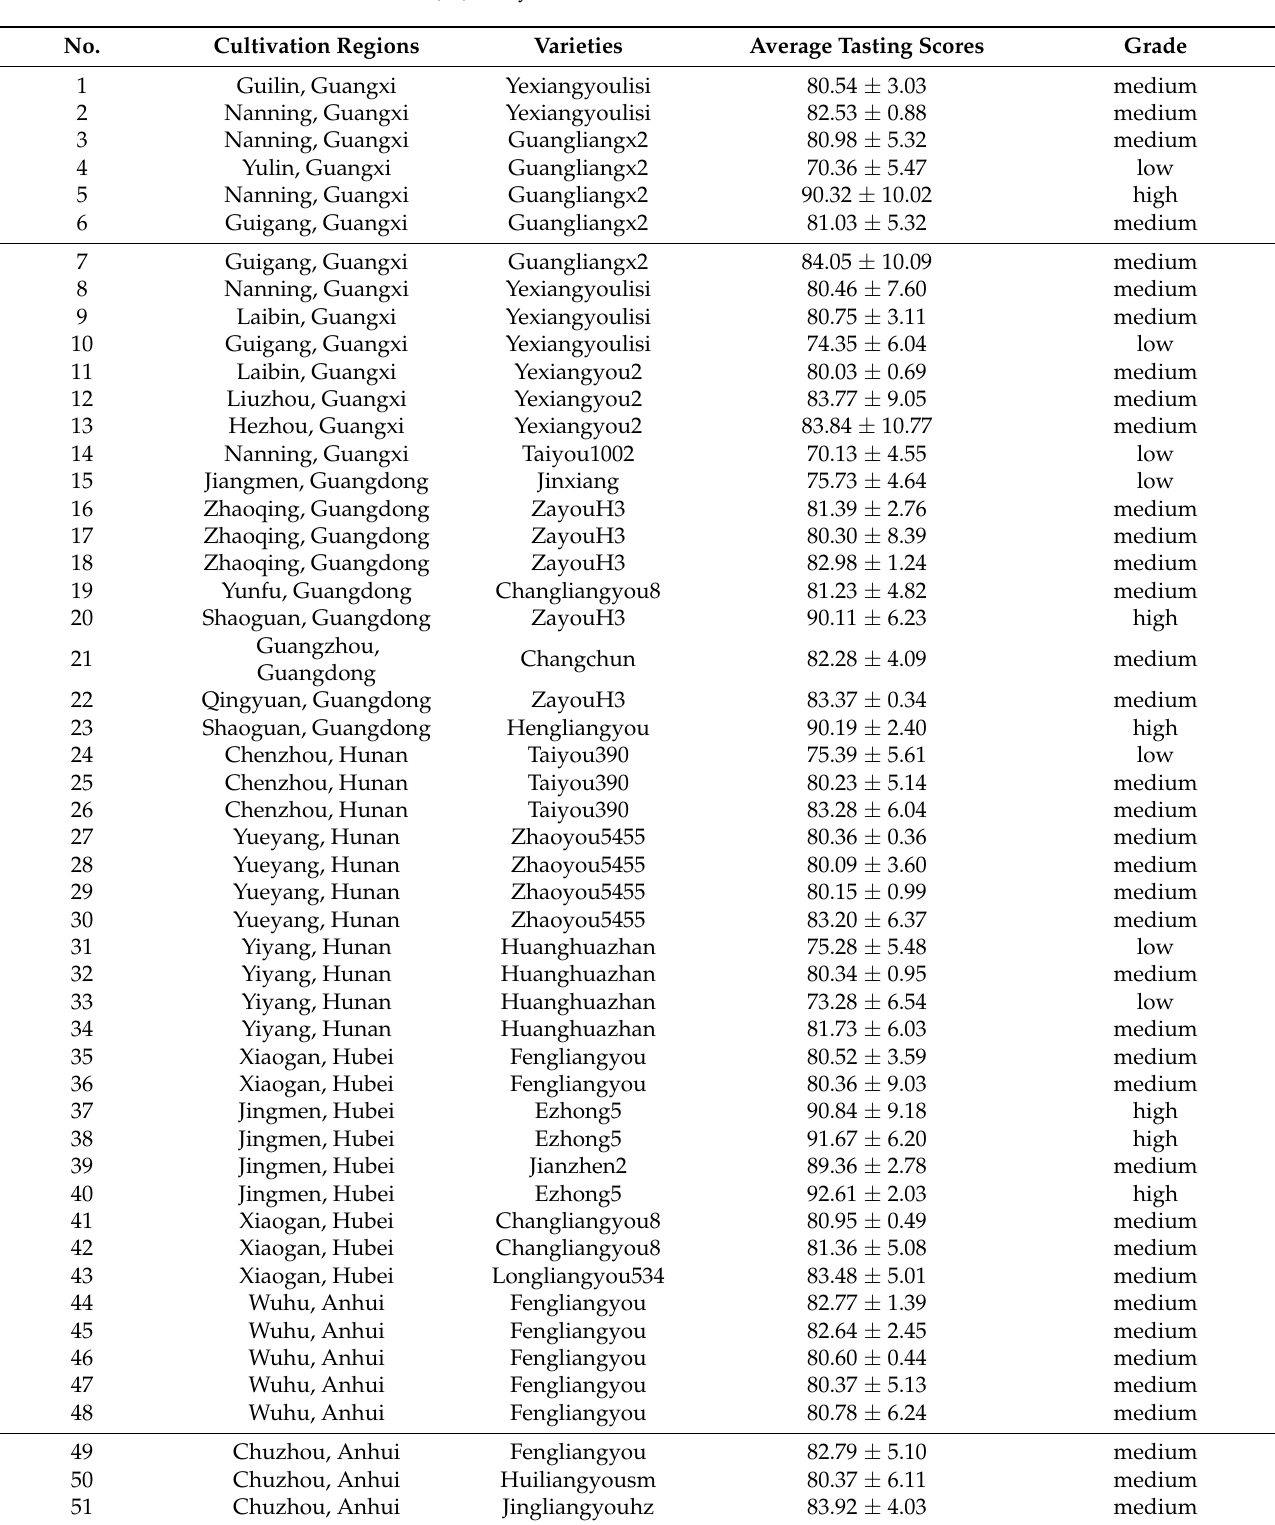
Table 1. Cultivation region, variety, grade, and average tasting scores with standard deviation (SD) of indica rice (IR)